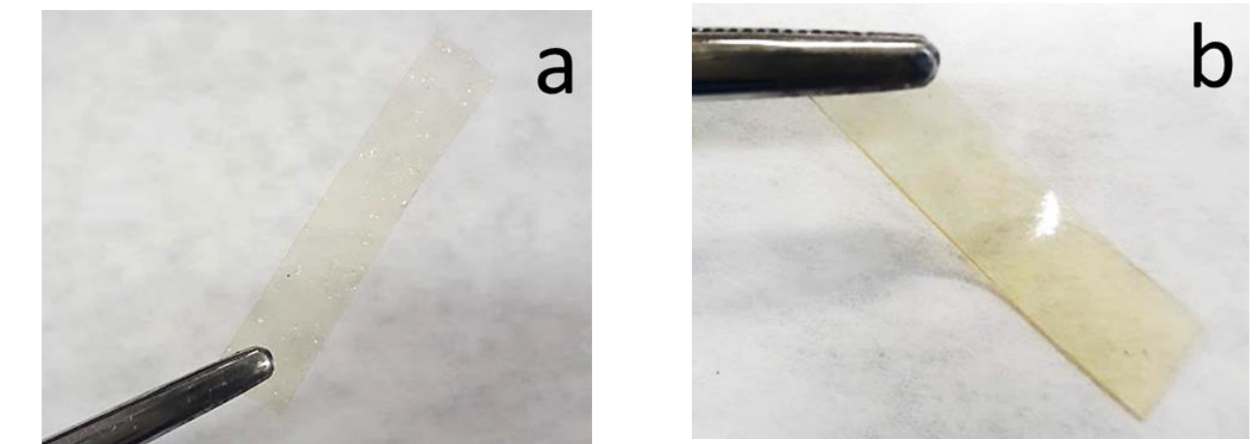
Figure 1. Photographs of rectangular sample films ( a ) F0/0 and ( b ) F5/0